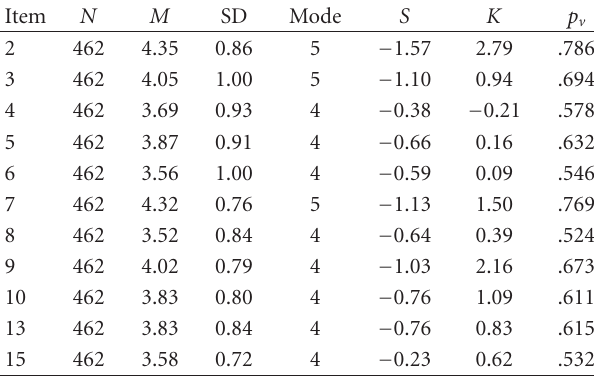
Table 3: Statistical parameters of the first validation.